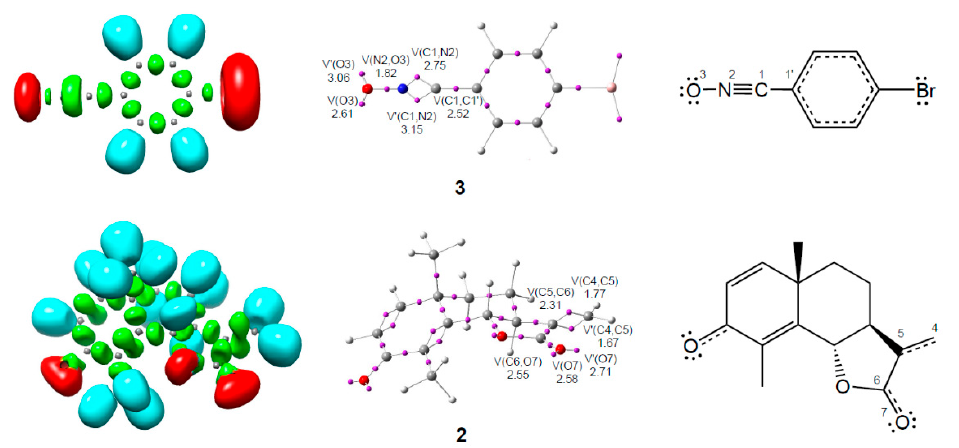
Figure 1. MPWB1K/6-311G(d,p) localization domains (isovalue = 0.75) and basin attractor positions together with the most significant valence basin populations, and the proposed Lewis-like structures of α -santonin derivative 2 and p -bromophenyl nitrile oxide 3 . Electron localization function (ELF) valence basin populations are given in average number of electrons, monosynaptic valence basins are shown in red, disynaptic valence basins are shown in green, protonated basins are shown in blue, and core basins are shown in grey.